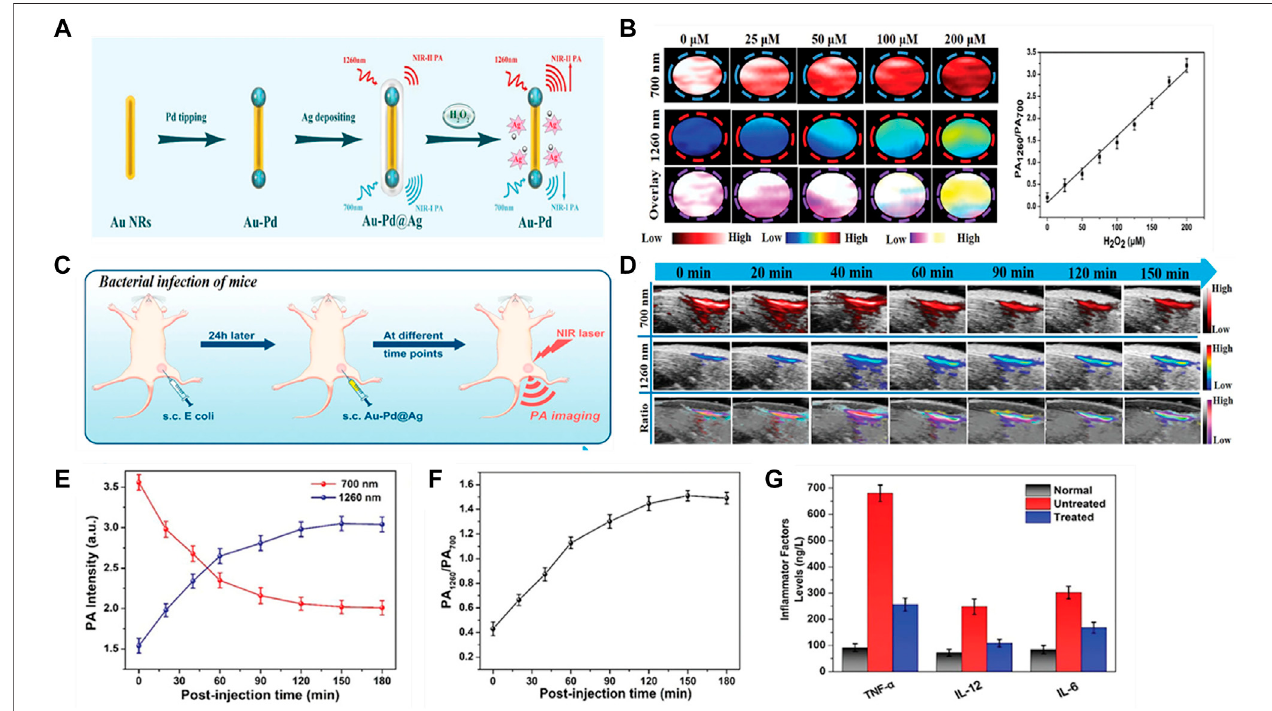
FIGURE 8 | ROS-responsive ratiometric NIR PA imaging (A) Schematic illustration of the synthetic route of Au – Pd@Ag nanoprobe. (B) PA images at 700 and 1,260 nm of Au – Pd@Ag before and after incubated with different concentration of H 2 O 2 , and the ratiometric PA intensity (PA 1260 /PA 700 ) as a function of the concentration of H 2 O 2 . (C) Schematic illustration showing detection of H 2 O 2 in the in fl amed region of mice infected subcutaneously with E. coli using the Au – Pd@Ag nanoprobe. (D) Representative PA images of the infected region before and after subcutaneous (s.c) injection of Au@Ag – Pd nanoprobe. (E) Time-dependent changes in PA 700 and PA 1260 intensities following Au – Pd@Ag injection. (F) Ratiometric PA 1260 /PA 700 as a function of time in the above. (G) The level of in fl ammatory factors(includingTNF- a ,IL-12,IL-6)inthedifferentiallytreatedanimals(reproducedfrom(Yeetal.,2020)withpermissionfromWILEY-VCHVerlagGmbHandCo.KGaA,